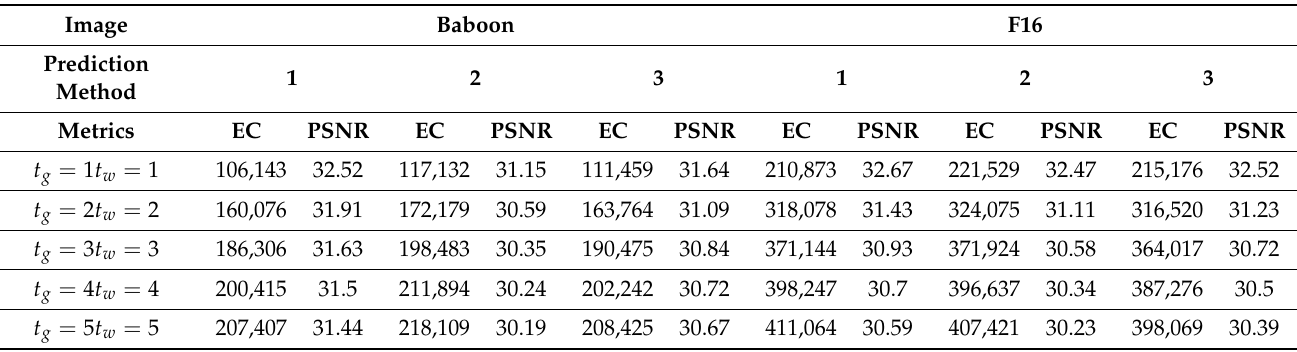
Table 7. Comparison of the performance of our triple-RDH method between images “Baboon” and “F16” for parameters t g , t w between 1 and 5 ( n = 3, pp 1 = 1, and pp 2 = − 1).